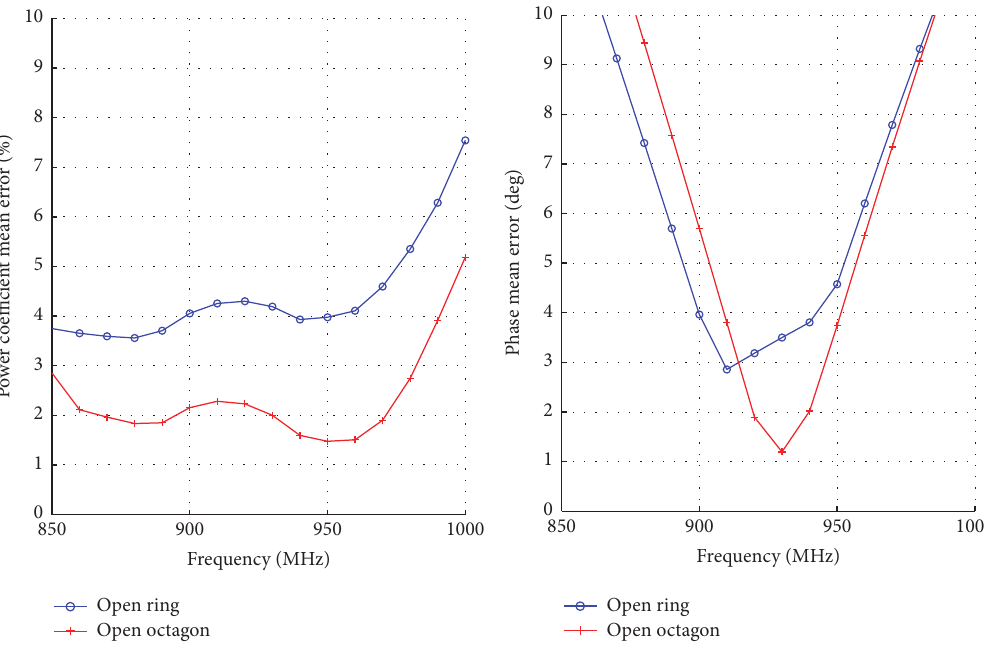
Figure 4: Nonuniform series divider power coefficient and phase mean errors for both open ring and open octagon implementations.